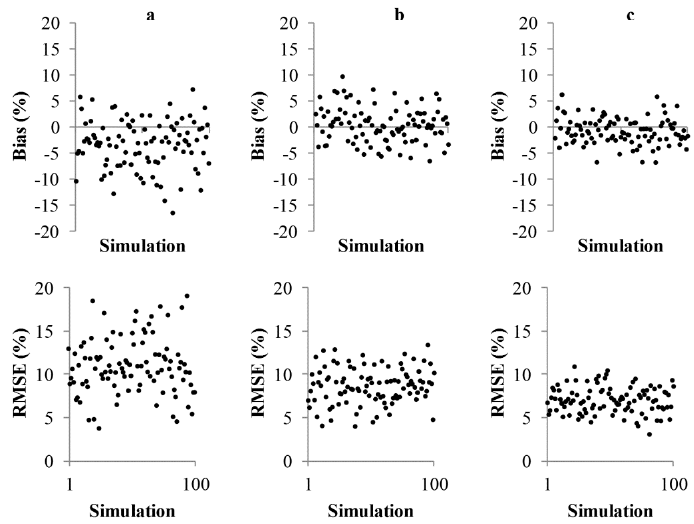
Figure 3. Bias and RMSE for simulations using the area approach in stand 1 ( a ), stand 2 ( b ), and stand 3 ( c